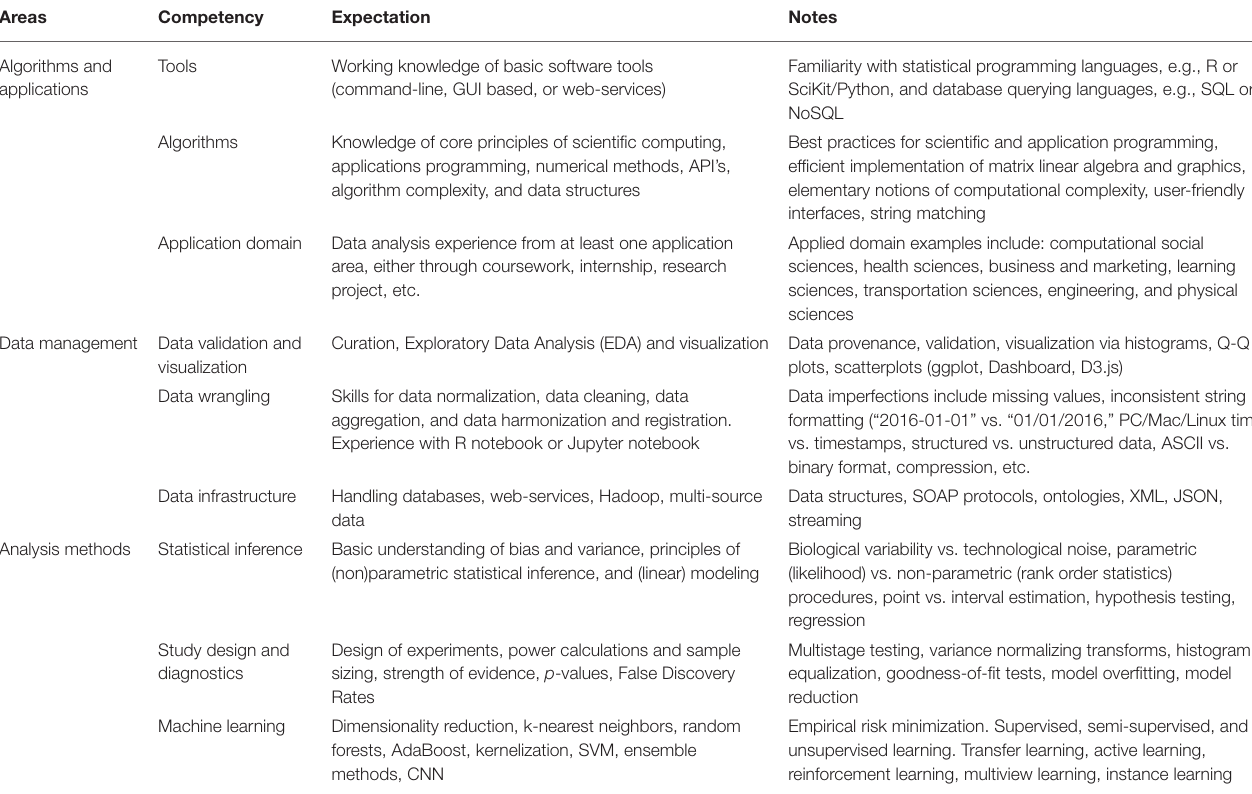
TABLE 4 | Expected program graduate’s competencies.